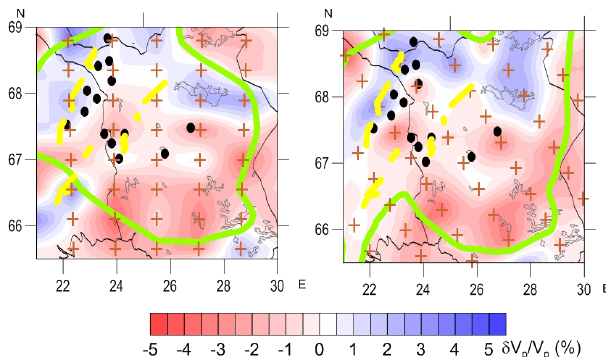
Figure 9. Horizontal cross sections of 3-D velocity structure recon- structed with the SIMULPS14 for the depth of 10km and Region 1. Left subplot shows the result for normal inversion grid and right subplot shows the result for the inversion grid which is rotated to an angle of 30 ◦ anticlockwise from the north. Green contours re- strict the area with resolution more than 0.5. Yellow lines denote postglacial faults (detailed description is presented in Fig. 1). Black points show hypocentres of the earthquakes relocated in the 3-D model for which 6 ≤